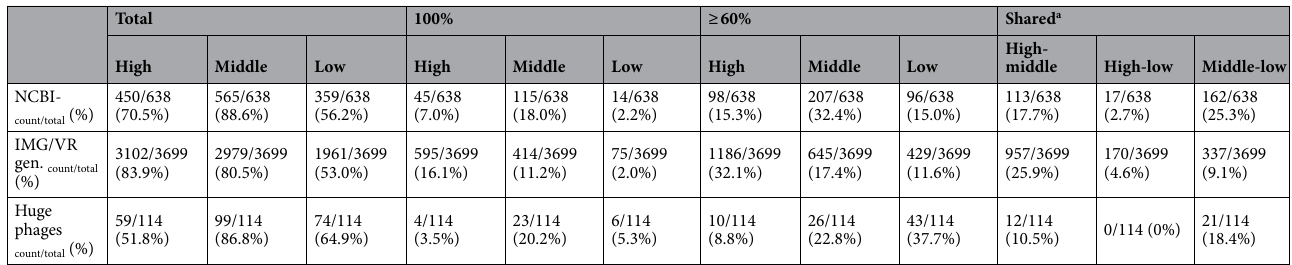
Table 1. Proportion of phages within income classes. gen. genomes. The total is the database total and not the income class total. Number of shared phages are phages that in the excluded class contributes with ≤ 20%